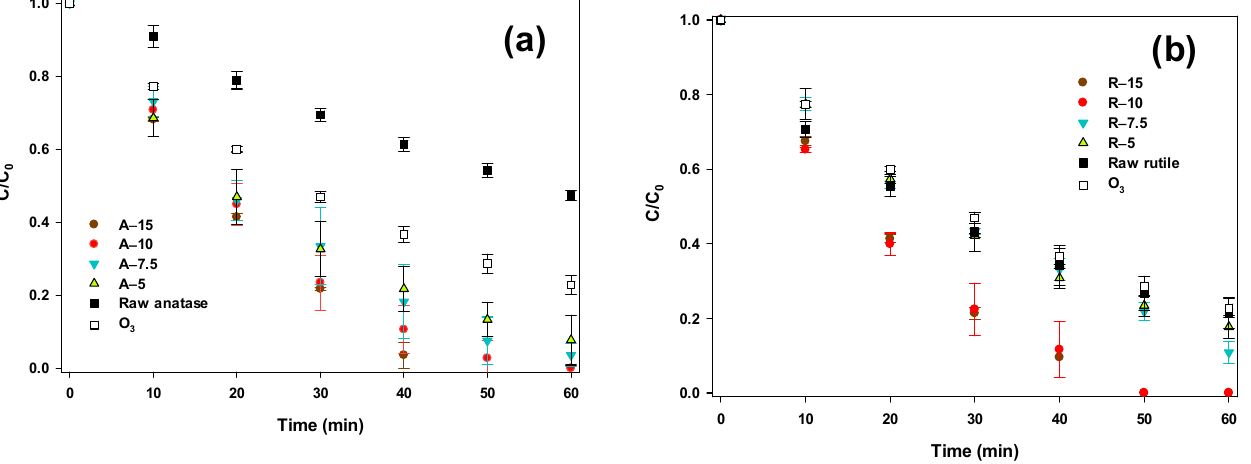
Figure 1. Catalytic activities of synthesized titania catalysts originating from anatase ( a ) or rutile ( b ). (Initial concentration of phenol is 20 mg/L; introduced O 3 is 10 mg/L with a flow rate of 50 mL/min).